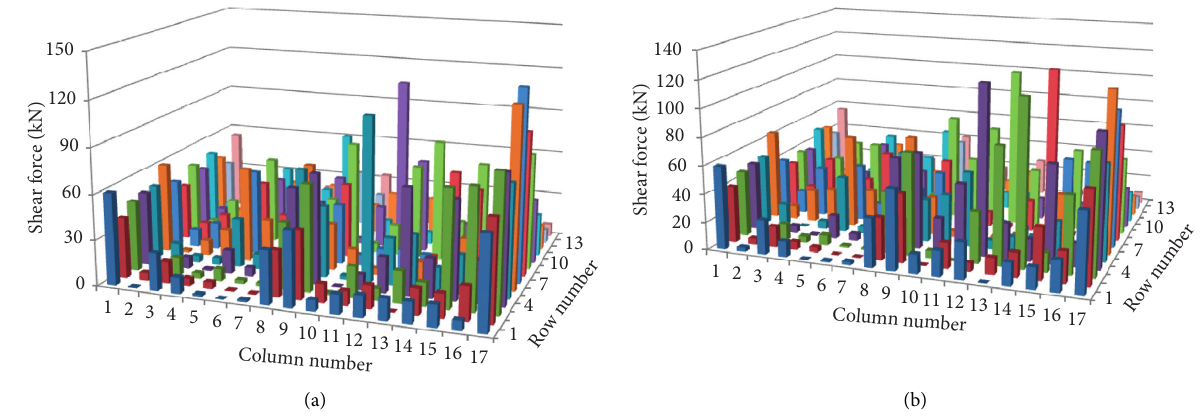
Figure 19: Vertical shear distribution of the stud group in GMX13 segment. (a) Midspan. (b) Side span.